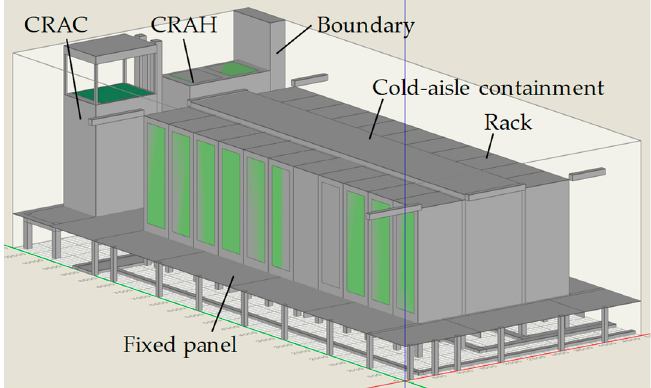
Figure 2. Model of verification room.